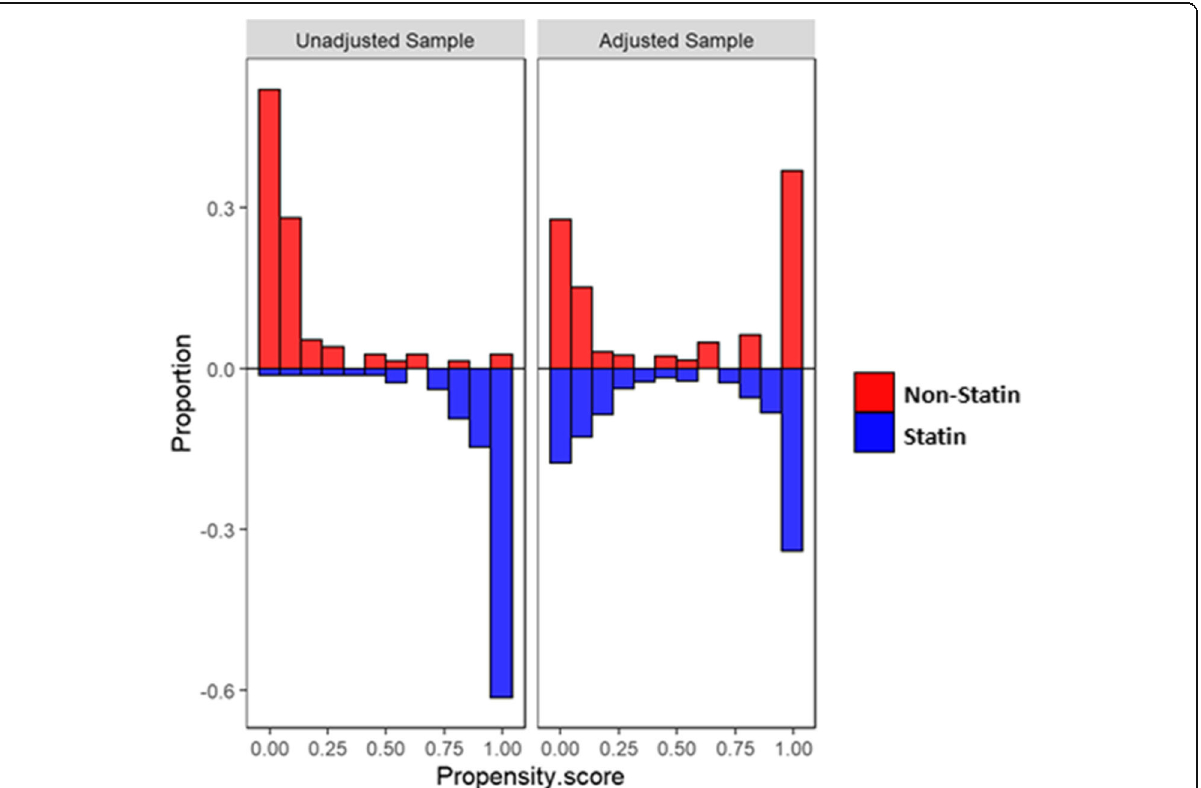
Fig. 2 Histogram and density distribution plots of the estimated propensity scores, before and after propensity score adjustment in statin and non-statin patient groups. The left side of the figure (unadjusted) shows that the non-statin group had more density on the right side of the plot versus the statin group that had more density on the left side of the plot. After adjustment (right side of the figure), both groups displayed similar densities. The results show that the two groups became more similar when considering mutual confounders that may affect the association between the main exposure variable (statins) and survival time. The C-statistic of the propensity score model was